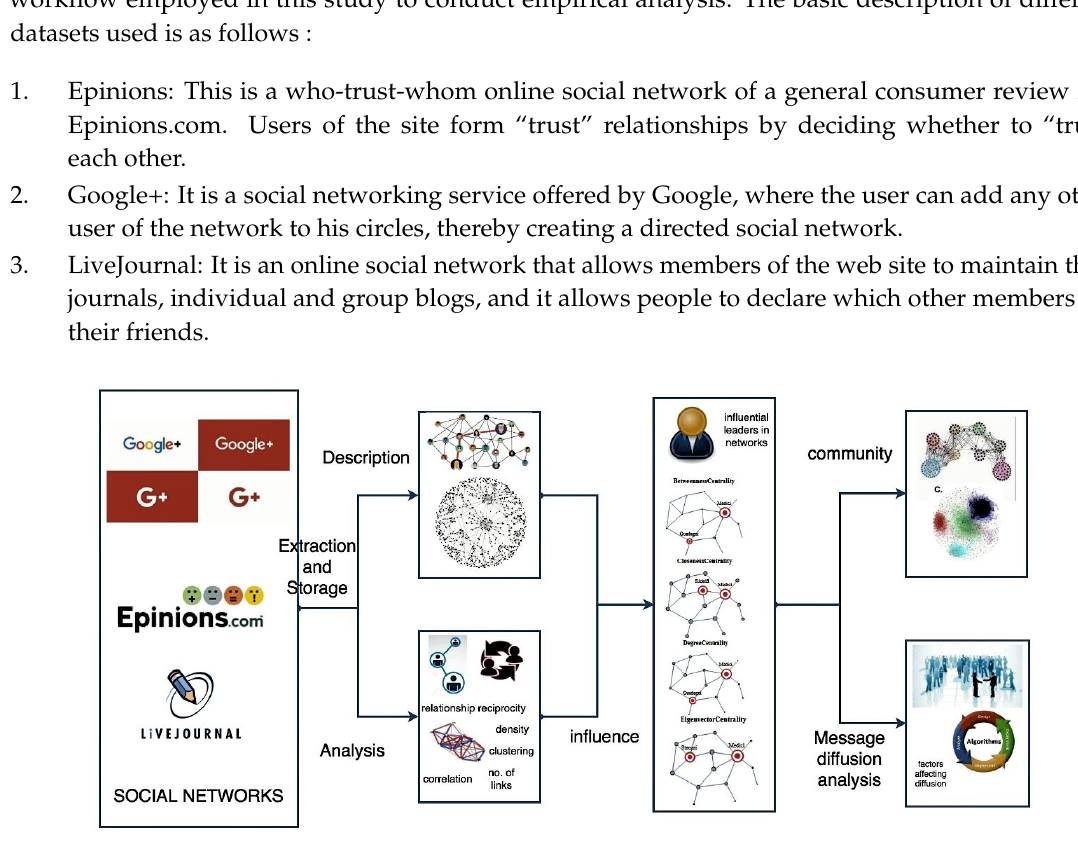
Figure 2. An overview of the methodology used in the empirical